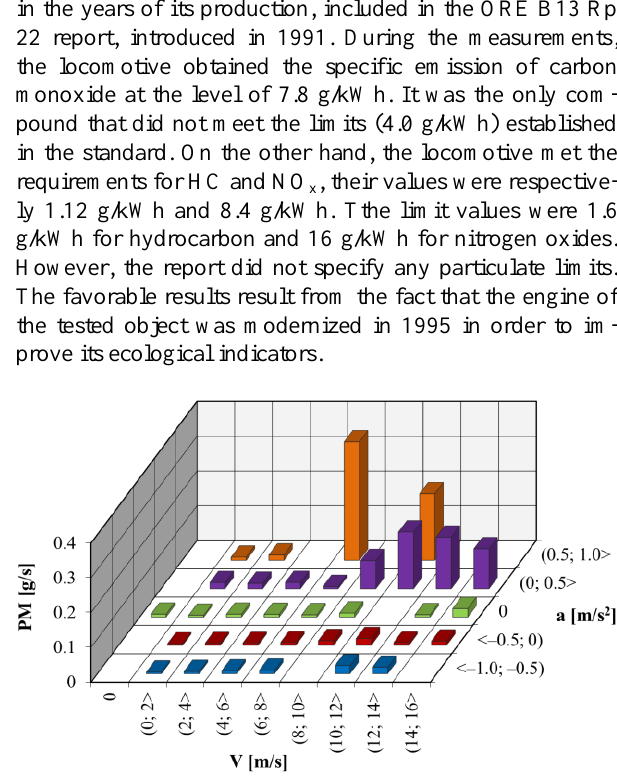
Fig. 14. PM exhaust emission intensity of the tested vehicle in speed and acceleration intervals